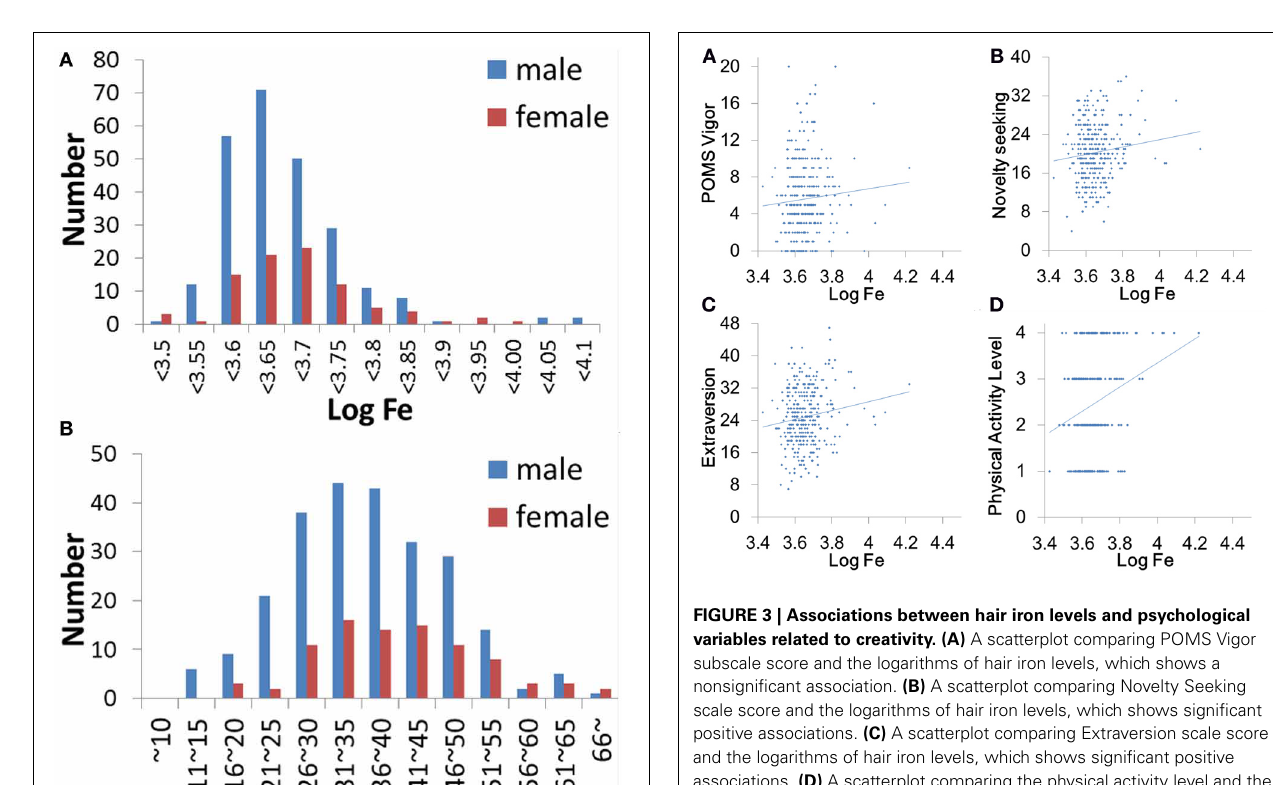
p = 0 . 002) significantly mediated the relationship between hair mineral levels and creativity. However, novelty seeking did not significantly mediate the relationship between hair mineral levels and creativity ( Z = 1.484, p = 0 . 138).